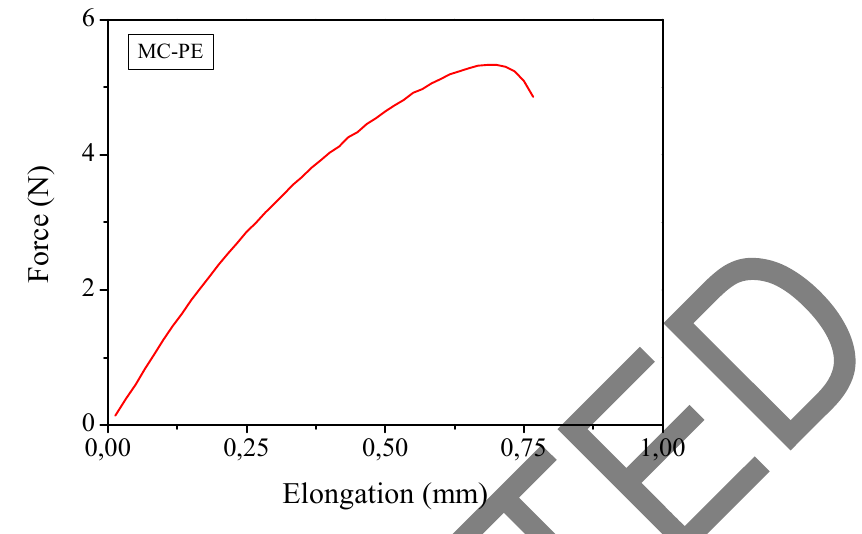
Figure 6. Mechanical measurements through traction test of the reinforced MC-PE at ambient temperature.